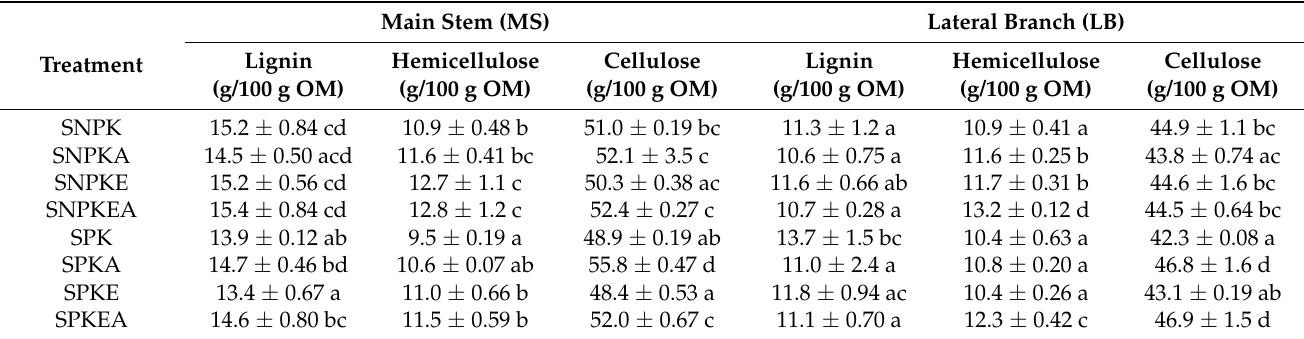
Table 7. Contents of lignin, hemicellulose, and cellulose in the main stem and lateral branches of K. pentacarpos seedlings grown in polluted soil in the presence or absence of NaCl or/and EDDS for five months. Each value is the mean of 3 replicates and vertical bars are S.E. Values exhibiting different letters are significantly different at p < 0.05 according to SNK test.